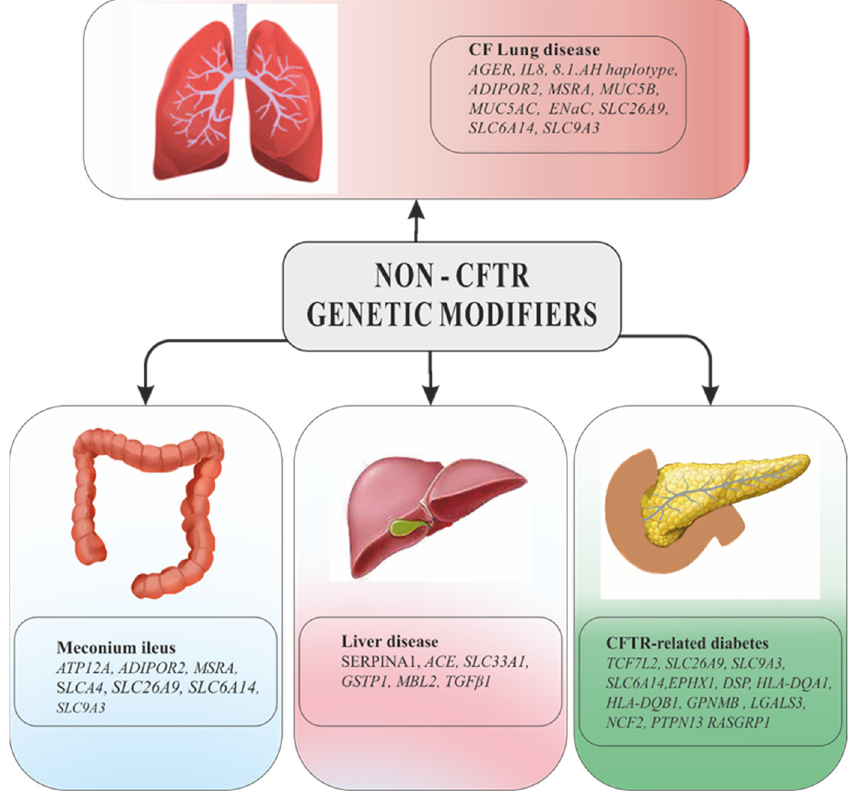
Figure 3. Possible candidate genes that modify the pulmonary phenotype and comorbidities associated with cystic fibrosis.